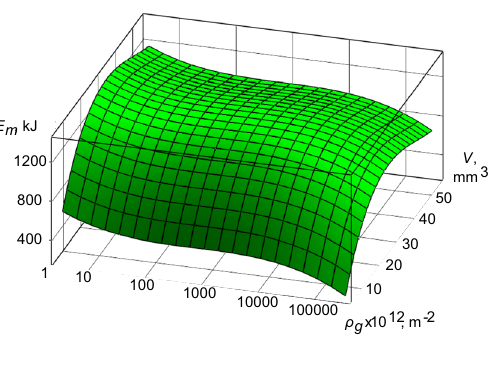
Figure 4. The energy-mass transfer in the TS “crankshaft-insert” for the operating conditions of diesel engine 10D100 during the processes of critical wear of interacting